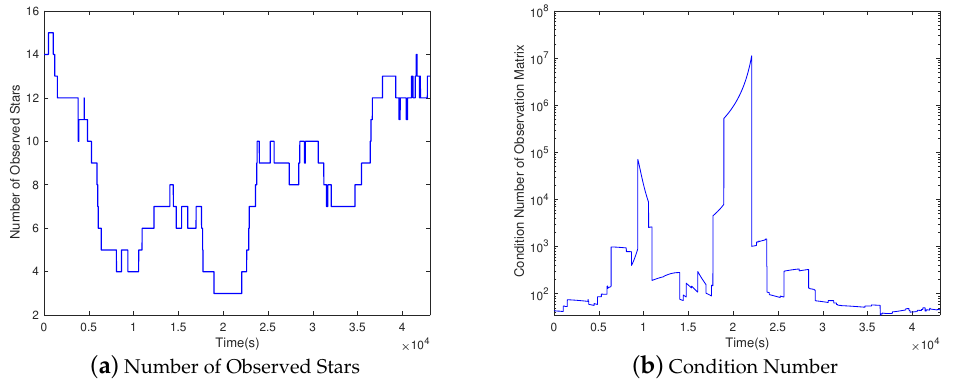
Figure 3. Figure ( a ) is the figure of number of observed stars. The abscissa is sampling time. Figure ( b ) is the figure of condition number of observation matrix. The abscissa is sampling time. The abscissas in follow figures are the